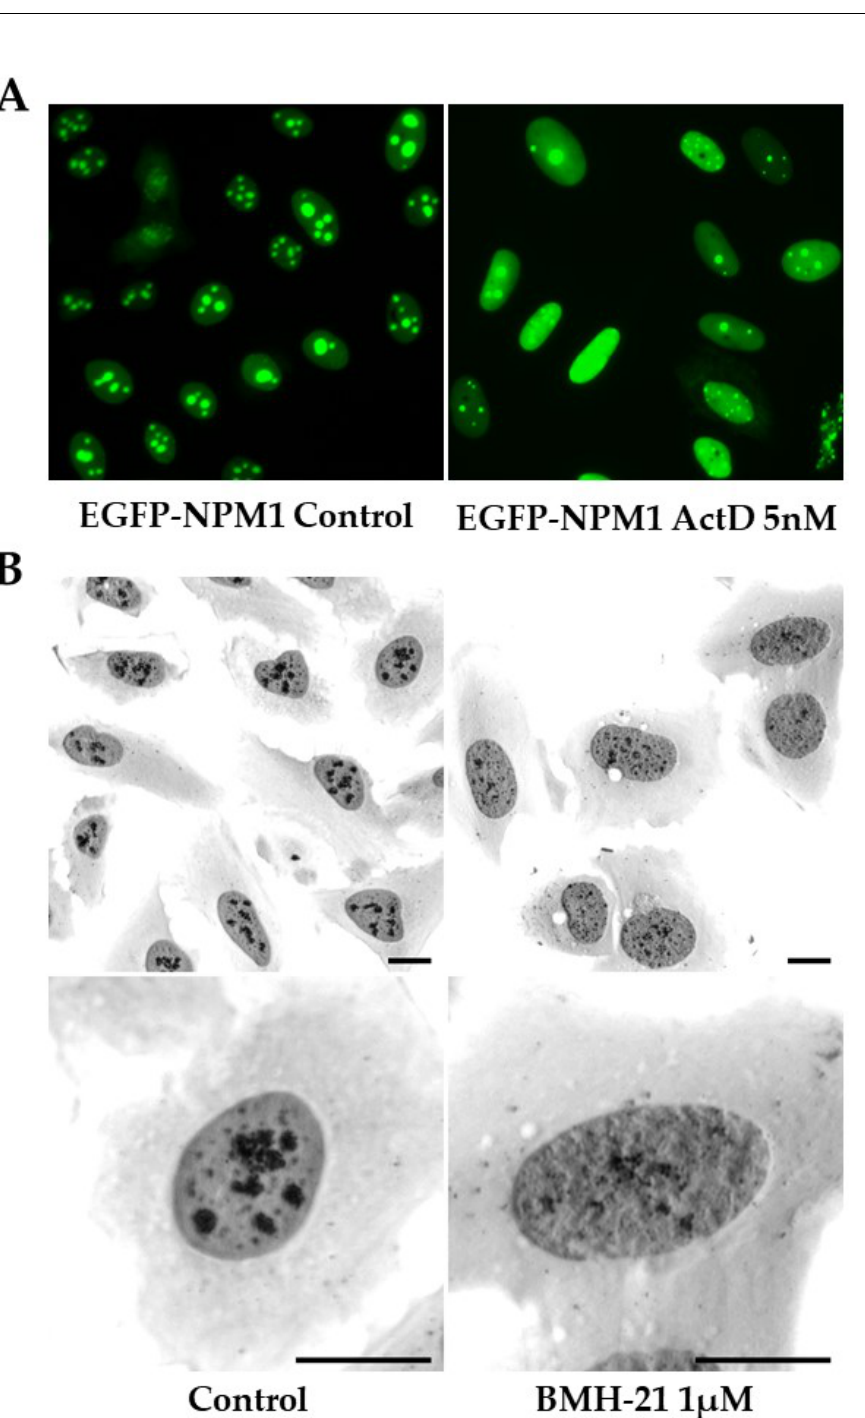
Figure 3. Examples of how ActD and BMH-21 affects nucleolar markers. ( A ) EGFP-NPM1 intracel- lular re-distribution upon treatment with a low concentration of ActD (5nM). On the left control, live unfixed U2OS cells; on the right, U2OS cells treated with ActD. The solvent for ActD in this experiment was ethanol. Note the more intense nucleoplasmic signal, while the round nucleolar areas have shrunken in the ActD-treated sample. Image by M. Lindström. ( B ) Nucleolar disruption induced by BMH-21 in U2OS cells. AgNOR staining of U2OS cells treated with DMSO (left) or 1 µ M of BMH-21 (right) for six hours. Zoom-in of select cells in the lower row. Scale bar 10 µ m. Image by A.